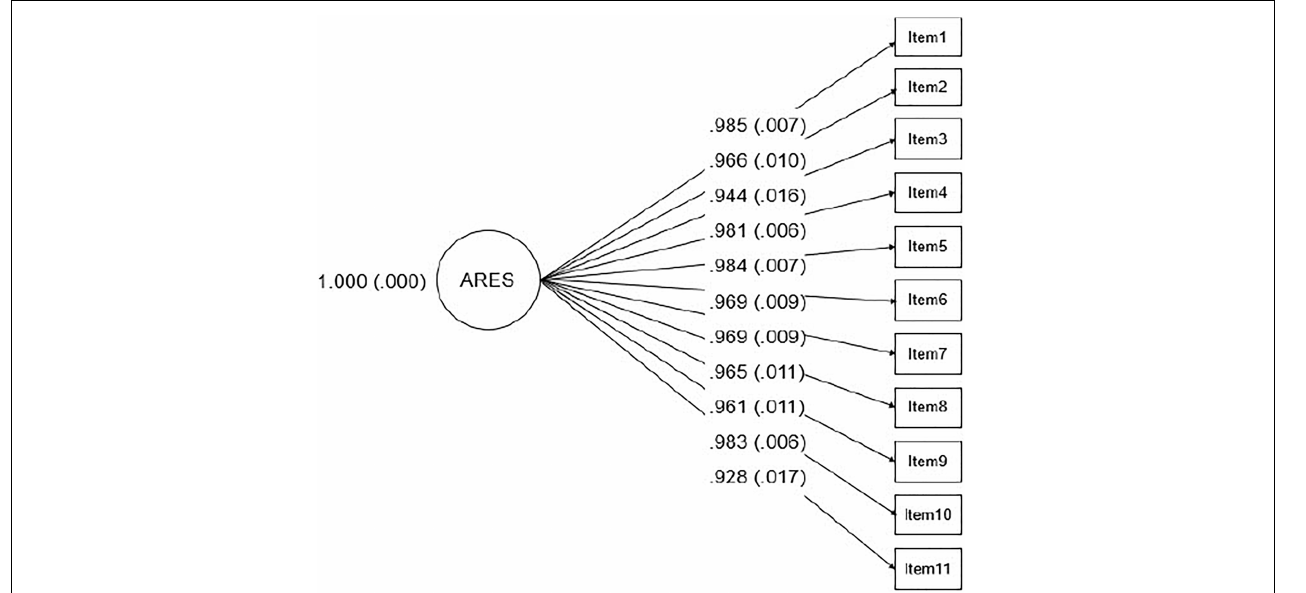
FIGURE 2 | Diagram of the latent model, representing one factor solution for ARES, with standardized factor loadings and their standard errors in parentheses.